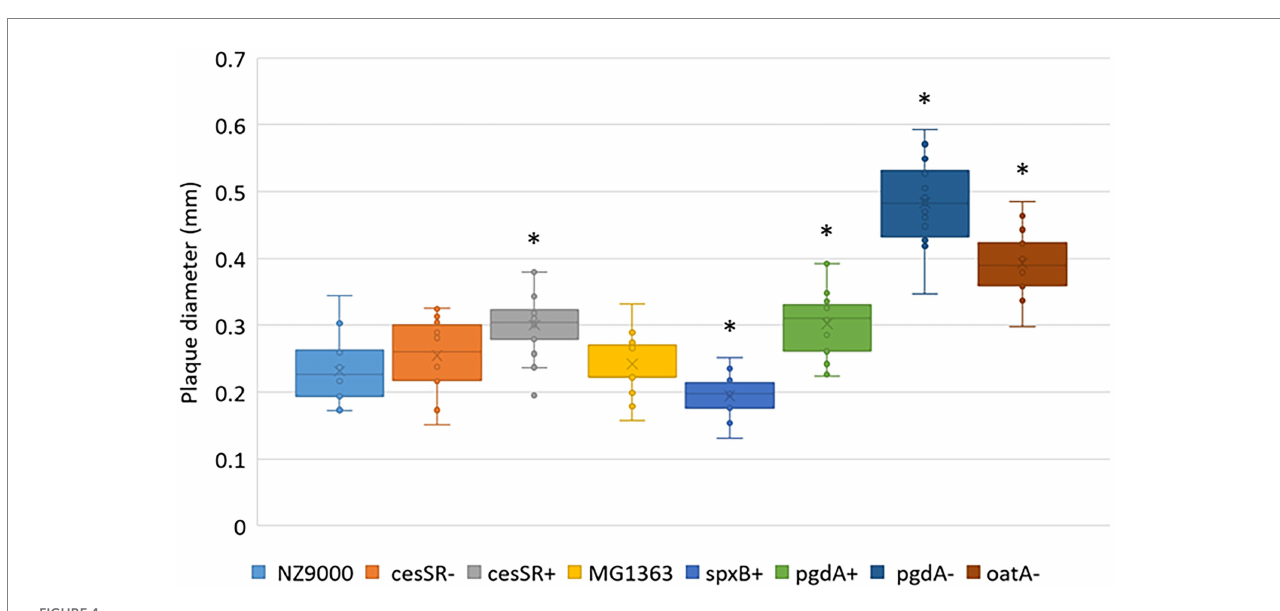
FIGURE 4 Average plaque diameter of phage c2 on lactococcal CES and PG mutants. *Significantly different ( p < 0.05) compared to the wild type L. cremoris MG1363 and